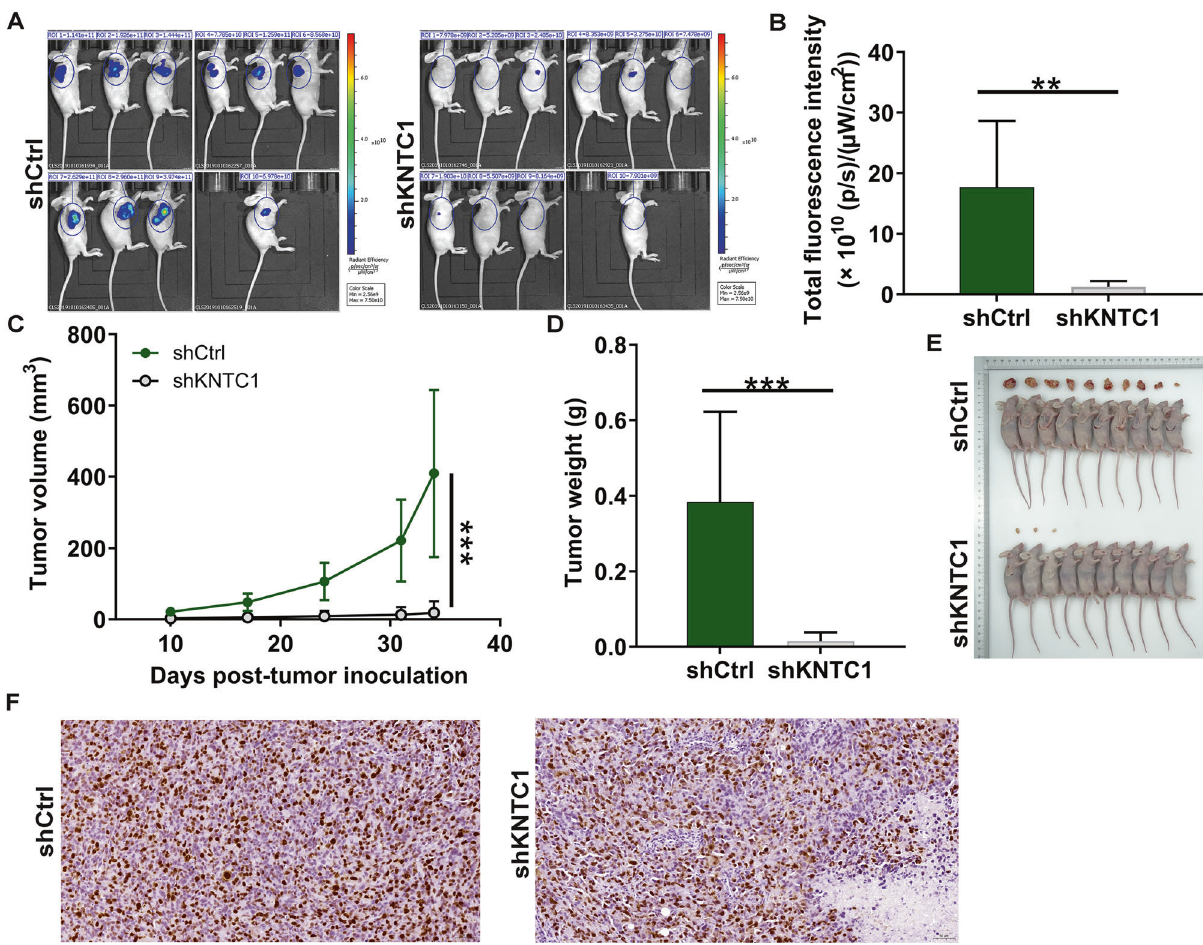
Fig. 5 KNTC1 knockdown inhibited NSCLC tumor growth in vivo. A A nude mice model of KNTC1 knockdown was constructed. B The fl uorescence intensity was obtained through injection of D -Luciferase before sacri fi cing the mice. C The volume of tumors was tested from feeding to sacri fi ce. D The weight of tumors was measured after sacri fi cing mice. E The photograph of tumors was taken after removing tumors. F The value of Ki-67 was detected by IHC in tumor sections. ** P < 0.01, *** P <